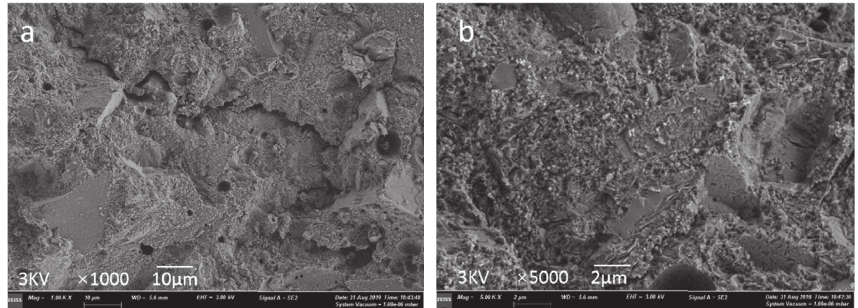
Figure 5: SEM micrographs showing the morphology specimen b3 at 1000x (a) and 5000x (b) magnification.